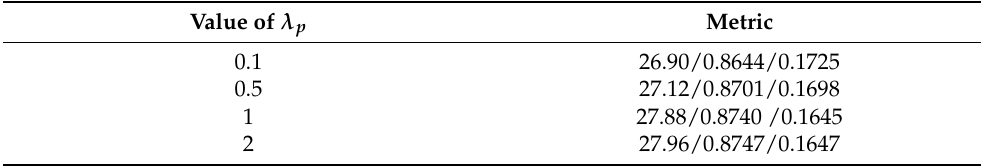
Table 5. Metric values (PSNR/SSIM/LPIPS) of the proposed PHMNet trained with different λ p hyperparameters. It is noted that other hyperparameters are fixed.